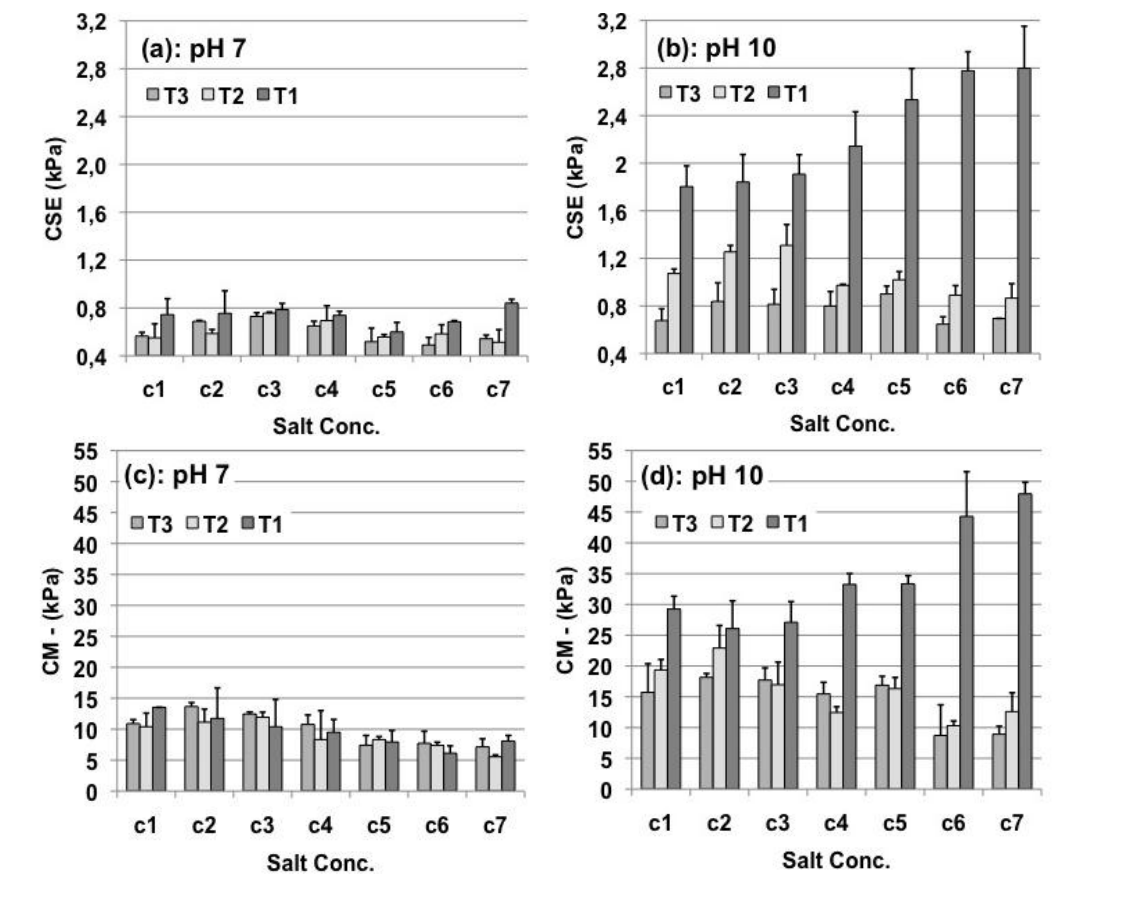
Figure 4. Compressive strain energy (CSE) ( a ) and compressive modulus (CM) ( c ) as a function of ionic strength (salt conc., c1, c2, c3, c4, c5, c6, c7) and temperature (T1 = 4 °C, T2 = 21 °C, T3 = 37 °C) for samples prepared at pH 7. CSE ( b ) and CM ( d ) as a function of ionic strength (salt conc., c1, c2, c3, c4, c5, c6, c7) and temperature (T1 = 4 °C, T2 = 21 °C, T3 = 37 °C) for samples prepared at pH